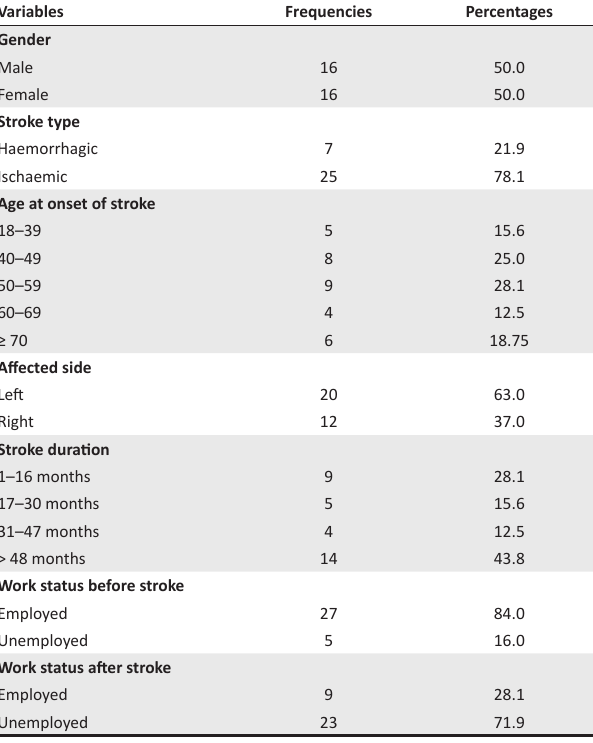
TABLE 3: Social demographic characteristics of pre-validation data ( N = 32). TABLE 4: Mean scores of SSQOL(E) and SSQOL(S) versions ( N =